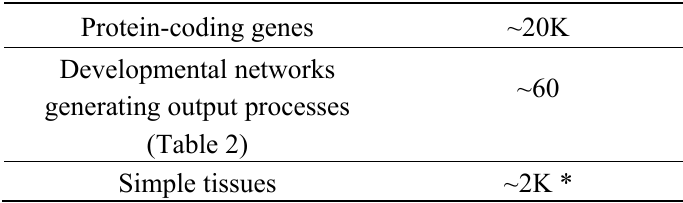
Table 1. Levels and numbers in the seven-week human